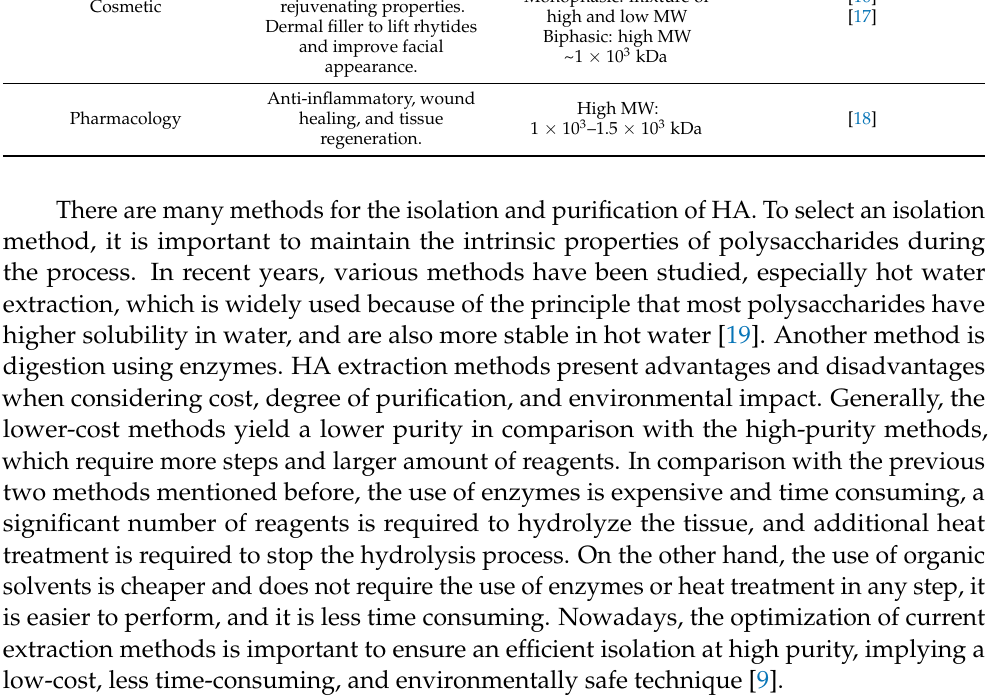
Skin care: anti-wrinkle, anti-nasolabial fold, anti-aging, and face rejuvenating properties. Dermal filler to lift rhytides and improve facial